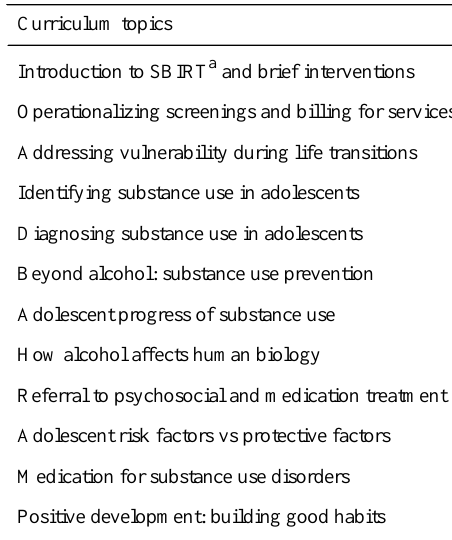
Table 3. Proposed curriculum